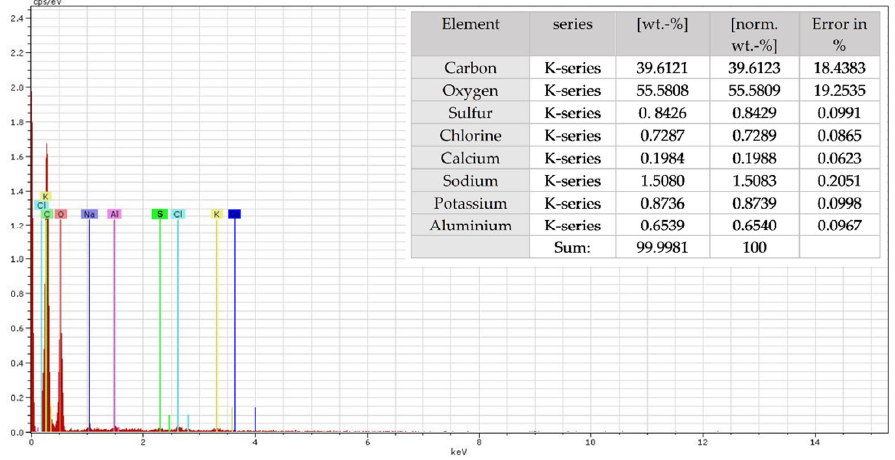
Figure 6. EDX spectrum for the spruce wood sample.